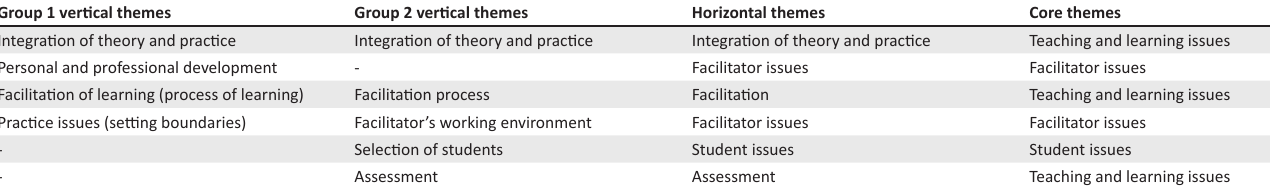
TABLE 1: Ranked themes per group, horizontal and core